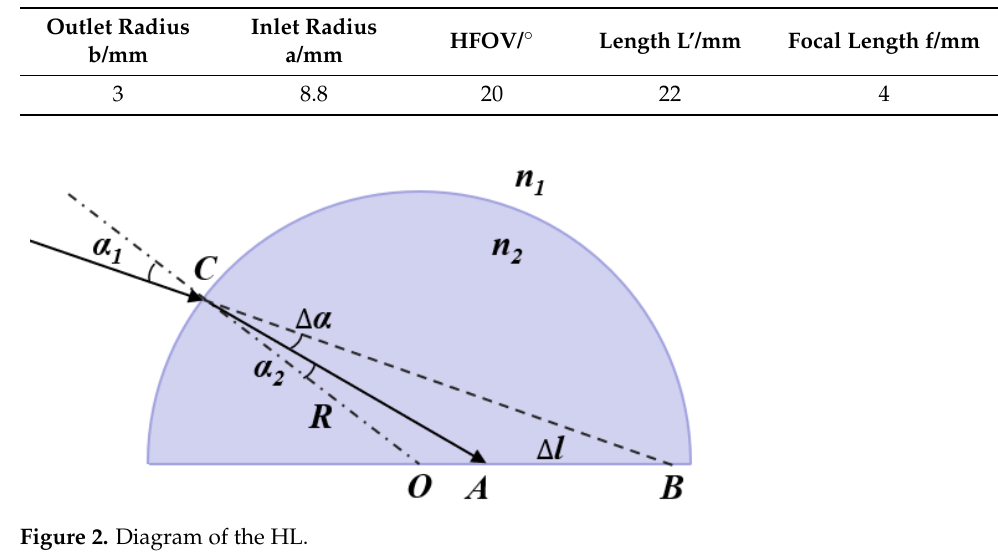
Table 1. Parameters of CPC.